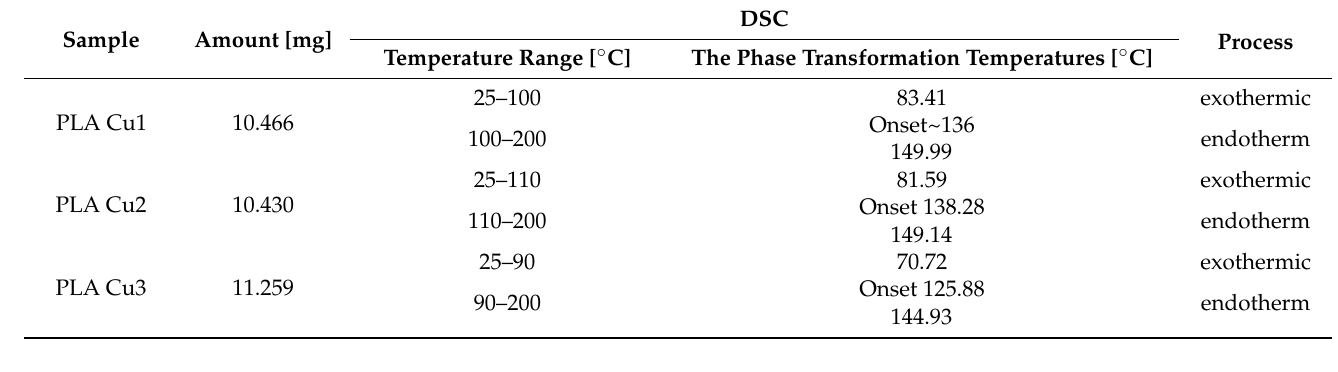
Table 5. The phase transformation temperatures and the identification of exothermic or endothermic processes.